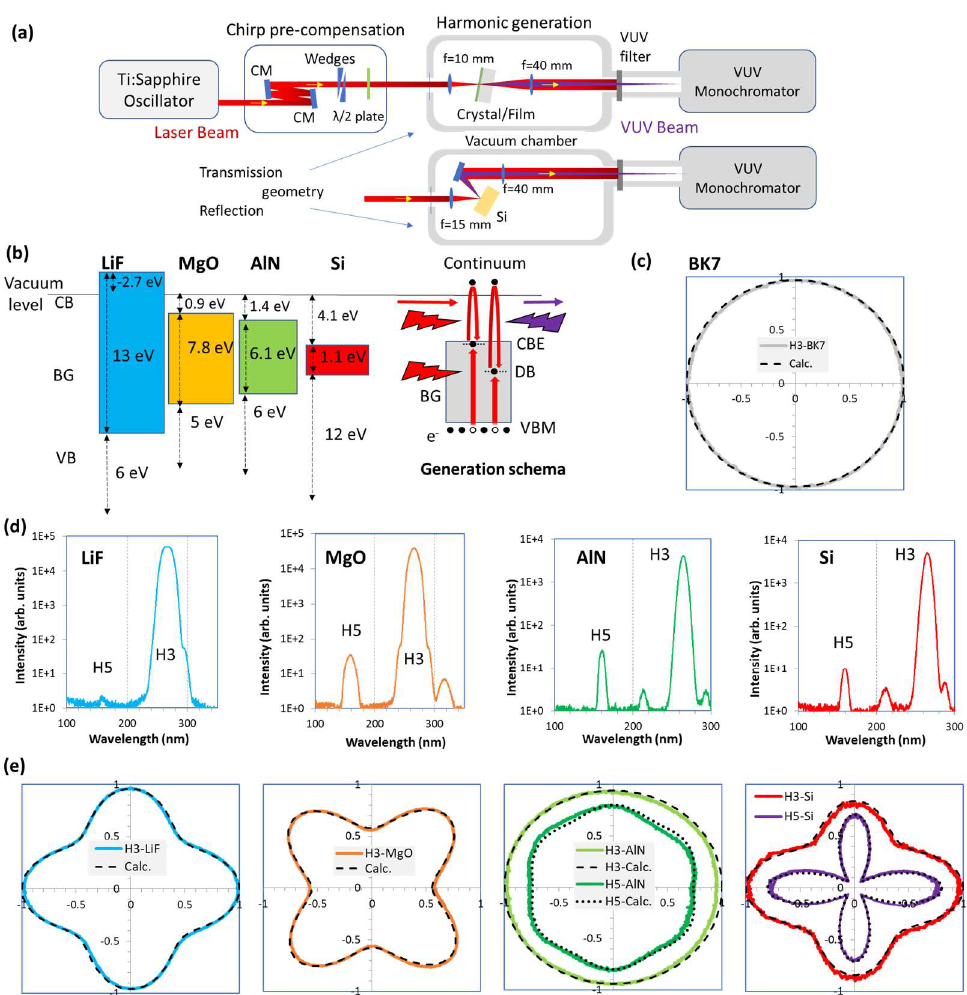
Figure 2. ( a ) Experimental setup using transmission geometry for the measurements of LiF, MgO, AlN and reflection geometry for Si. ( b ) Band gap (BG) positions of the used crystals (thin film) and the excitation scheme containing excitation from the delocalized valence band maximum (VBM) to the continuum through localized dangling bonds (DB) or localized conduction band edge (CBE) states. ( c ) Reference polarization measurement using amorphous BK7 glass. ( d ) Measured harmonic spectra containing H5 and H3 lines. ( e ) Measured polarization dependence of the harmonic intensities (color lines) and the calculations (black dashed and dotted lines).